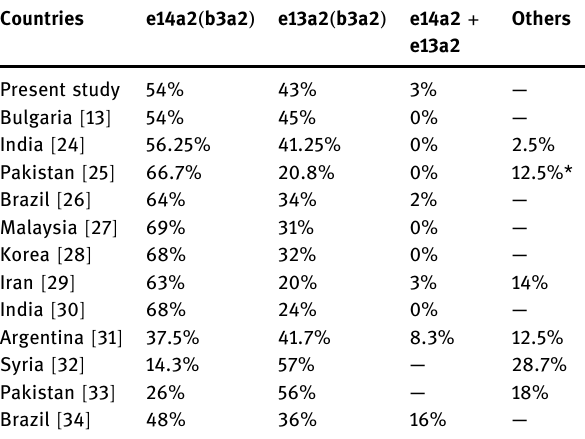
Table 4: Prevalence of BCR – ABL transcripts in di ff erent studies from various countries Countries e14a2 ( b3a2 ) e13a2 ( b3a2 ) e14a2 +